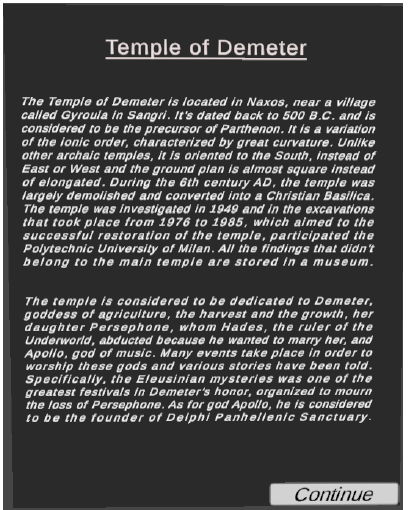
Figure 11: The informative text of the